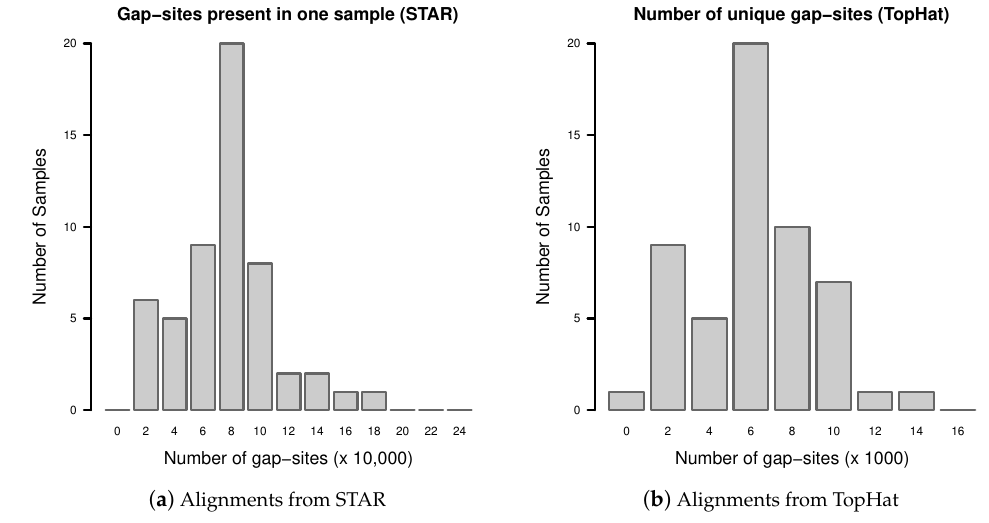
Figure A2. Number of unique gap-sites (gap-sites present in only one